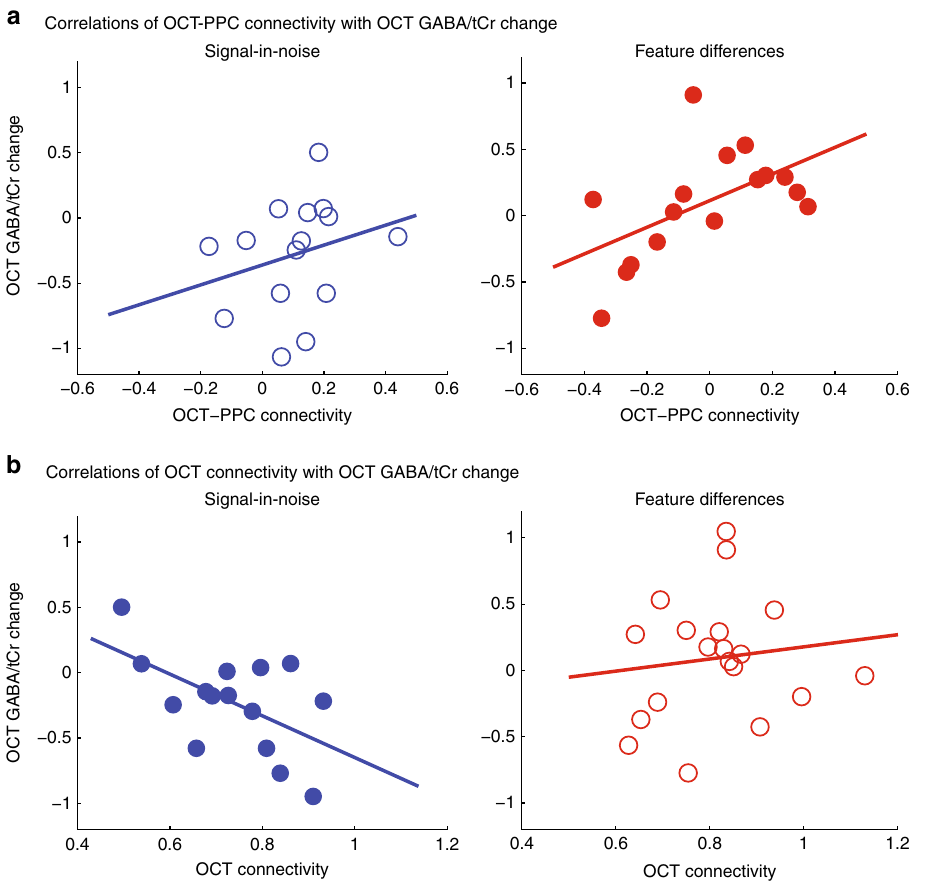
Fig. 6 Correlating functional connectivity with occipito-temporal cortex (OCT) γ -aminobutyric acid (GABA)/tCr change. a Skipped Pearson ’ s correlations showing a signi fi cant positive correlation of OCT-posterior parietal cortex (PPC) connectivity with OCT GABA/tCr change for the feature differences task ( n = 19, r = 0.55, CI = [0.13, 0.87]), but not the signal-in-noise task ( n = 16, r = 0.27, CI = [ − 0.08, 0.60]). We computed GABA/tCr change for each participant as the difference between GABA/tCr in the training block with maximum performance and GABA/tCr in the baseline block. b Skipped Pearson ’ s correlations showing a signi fi cant negative correlation of functional connectivity within the occipito-temporal cortex with OCT GABA/tCr change for the signal-in-noise task ( n = 16, r = − 0.55, CI = [ − 0.86, − 0.01]), but not the feature differences task ( n = 19, r = 0.12, CI = [ − 0.29, 0.51]). Signi fi cant correlations are indicated by closed symbols; nonsigni fi cant correlations by open